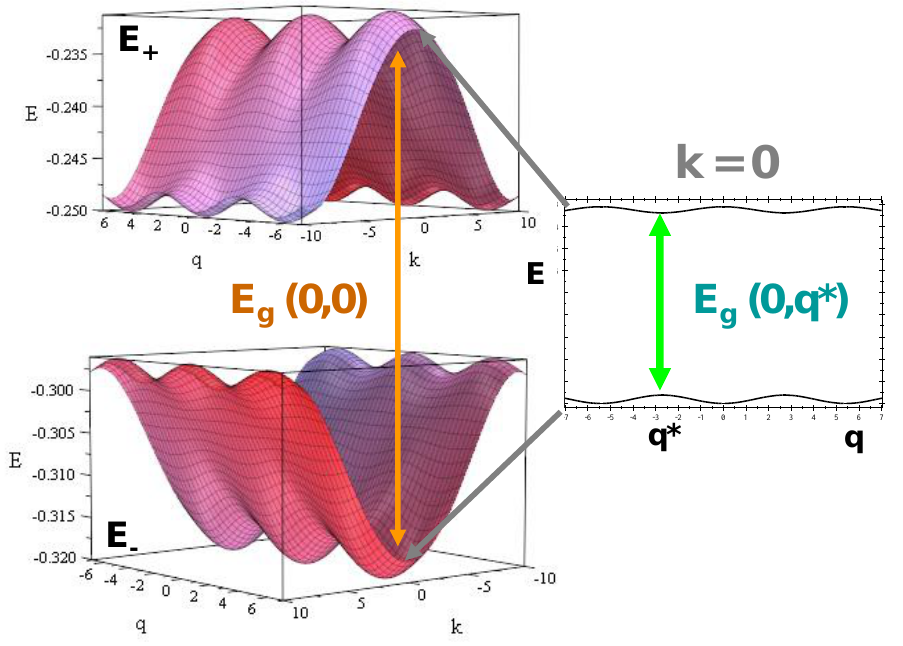
Figure 5. Electronic band structure for a polyG-polyC homopolymer. We have used the electronic model parameter values listed in Table 1 and the choice γ = 0 eV. The wavevectors k and q are measured in nm − 1 , and q ∗ = π / ξ 2.732 nm − 1 . The band structure of a polyA-polyT homopolymer is very similar (see Table 3) with the center of mass of the bands shifted upwards in energy by about 0.02 eV. Table 3. PolyG-PolyC and PolyA-PolyT band structure properties (measured in meV). We have adopted the values γ = 0, a GC = 16.6 eV, a AT = 17.4 eV, b GC = 30.9, b AT = 33.6.